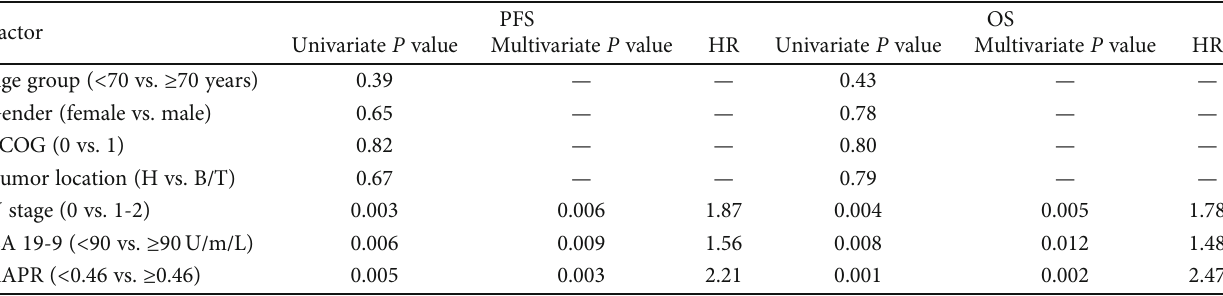
Table 2: Outcomes of uni- and multivariate analyses.